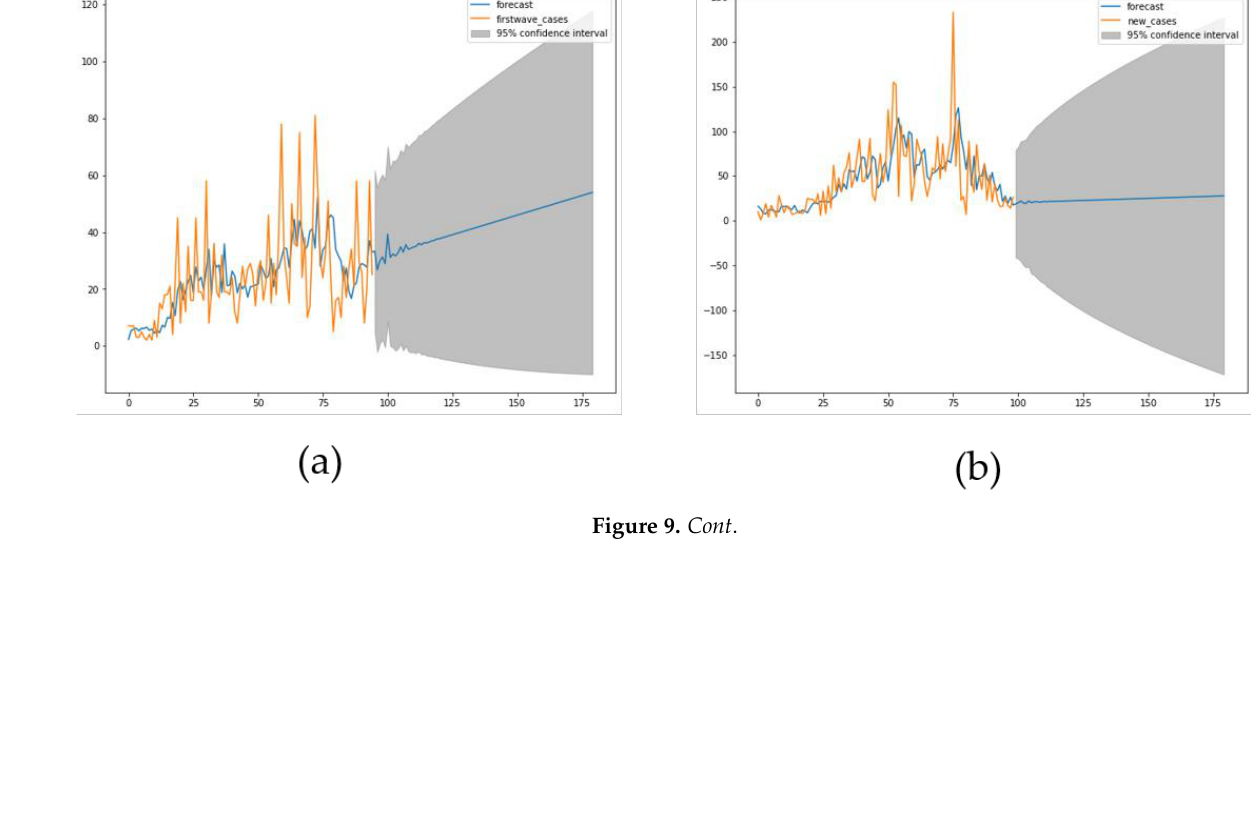
Figure 9. ( a ) First and ( b ) second wave forecast for Mali. ( c ) First wave forecast for Luxembourg. ( d ) Second wave forecast for Slovenia. 3.4. Clustering of Countries from Epidemic and Economic Variables 3.4.1. Hierarchical Clustering The hierarchical clustering allows developed and developing countries to be grouped into 5 separate clusters (Figure 10) and Principal Component Analysis into 3 separate clus- ters (Figure 11), one being a singleton corresponding to Spain (Figure 12).